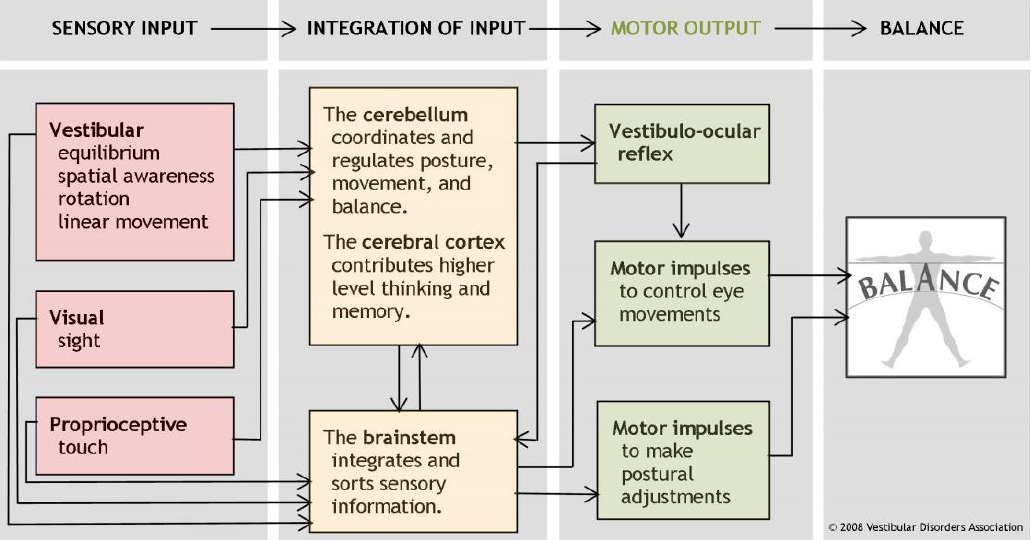
Figure 1. The human balance system. Courtesy of the Vestibular Disorders Association (vestibular.org).